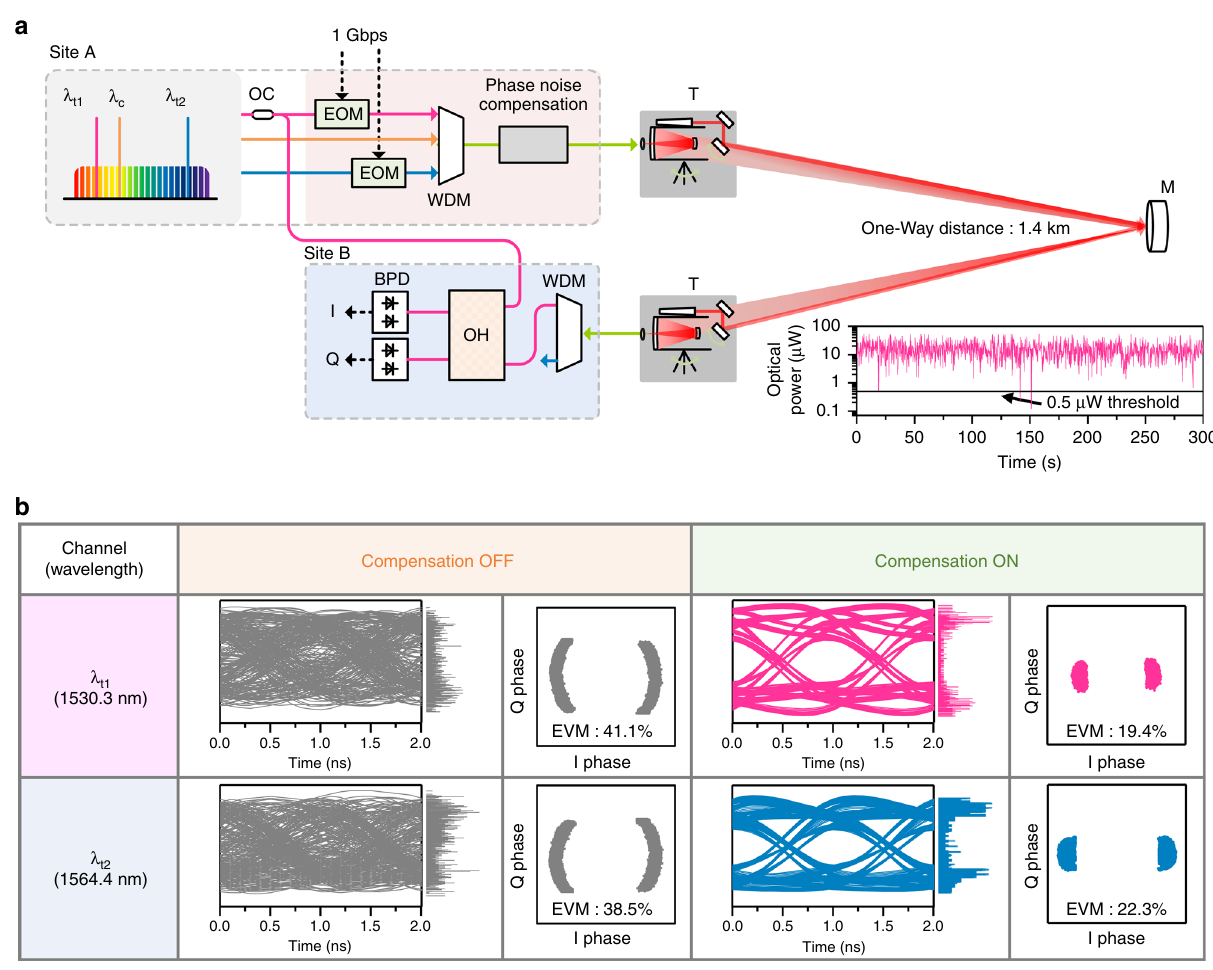
Fig. 5 Coherent optical communication test over a shortened link of a 1.4 km distance. a Binary phase-modulation is made at a 1 Gbps transmission rate using an electro-optic modulator (EOM). At the receiving site, incoming carrier signals are de-multiplexed through a wavelength division multiplexer (WDM), demodulated using an optical hybrid (OH) device, and fi nally converted by balanced photo-detectors (BPDs) to the in-phase (I) and quadrature- phase (Q) signals. (Inset) The measured optical power is for λ c transmitted with 100 mW power. b Performance evaluations in terms of eye diagrams, constellation diagrams, and error vector magnitudes (EVMs) before and after phase noise